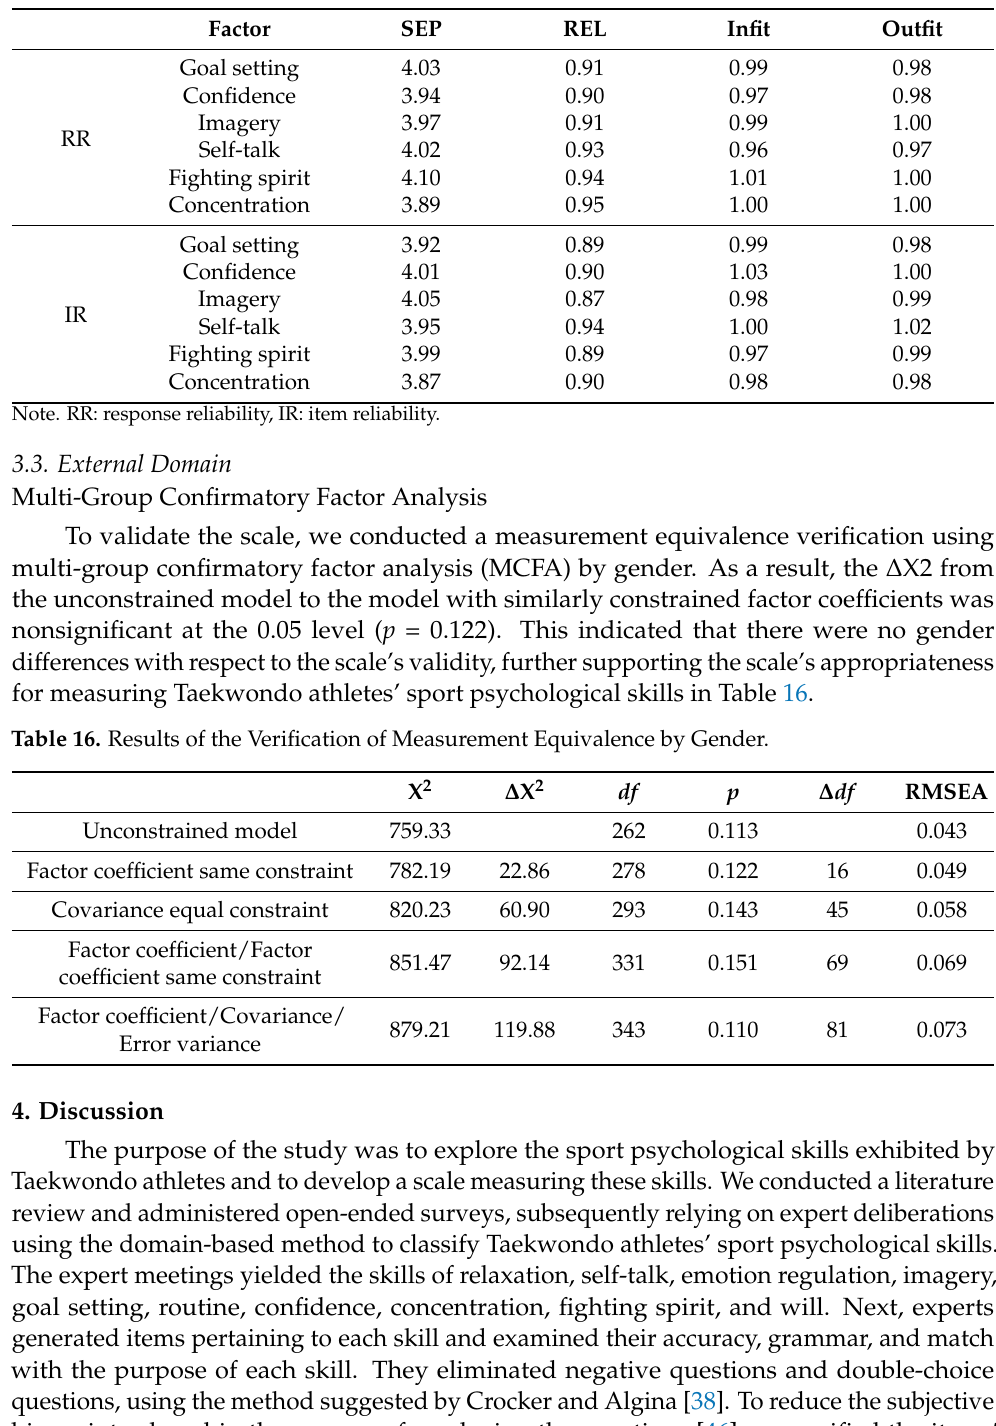
Table 15. Response and Item Reliability.